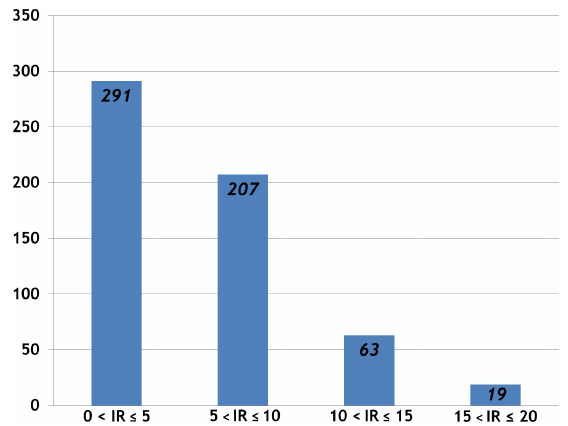
Figure 4. Robustness index (RI) distribution for all fault segments described in